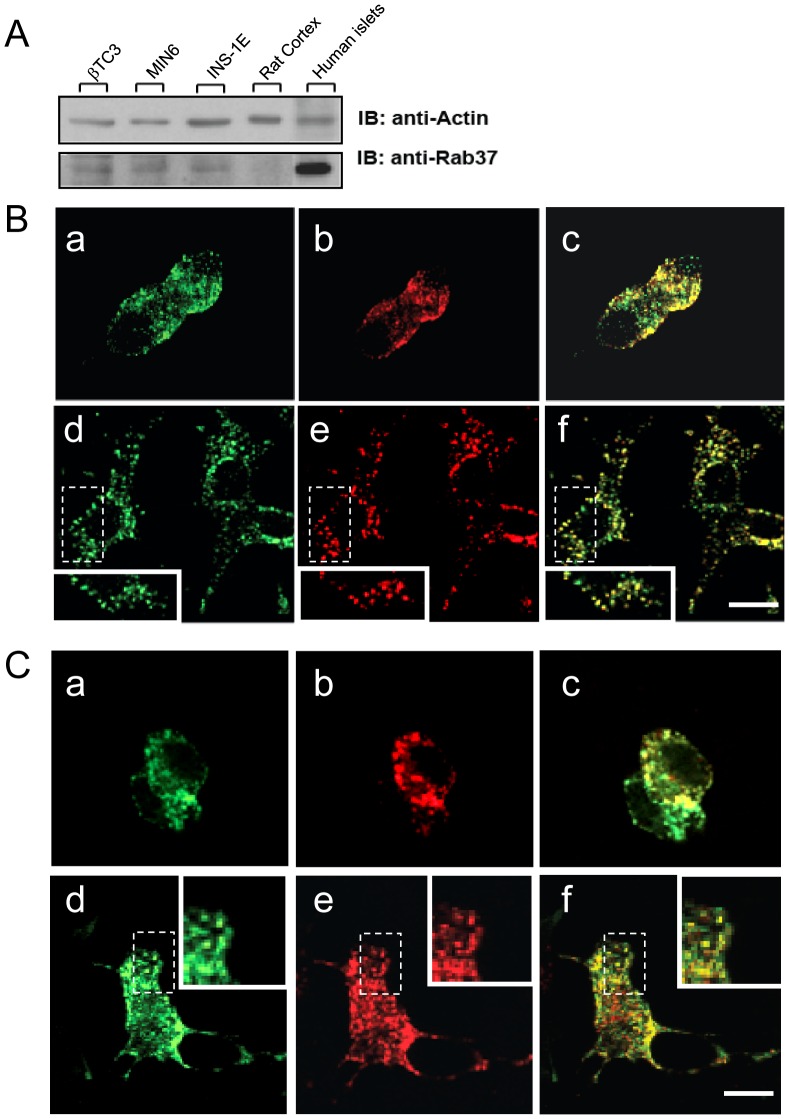
Rab37 GTPase is expressed in β-cells and is localized on insulin-containing granules.
A. Rab37 expression in insulinoma cell lines (in βTC3, MIN6B1 and INS-1E cells), rat cortex and human pancreatic islets. Total lysates were immunoblotted with an anti-mouse Rab37 polyclonal antibody (detected band at 25 kDa). Protein loading was verified with an anti-mouse actin monoclonal antibody. B. Insulinoma cell lines MIN6B1 (upper panel) and INS-1E (lower panel) were stained for Rab37 (a,d) and either insulin (b) or the GTPase Rab3a (d). After immunocytochemistry, the cells were observed on a confocal microscope for colocalization (c,f). Insets represent higher magnifications of the boxed regions. C. MIN6B1 (upper panel) and INS-1E (lower panel) cells were co-transfected with Rab37wt-EGFP (a,d) and with NPY-mRFP (b,e). Two days later, the cells were fixed and observed on a confocal microscope. Rab37wt-EGFP co-localizes with NPY-containing large dense core granules (c,f). Insets represent higher magnifications of the boxed regions.